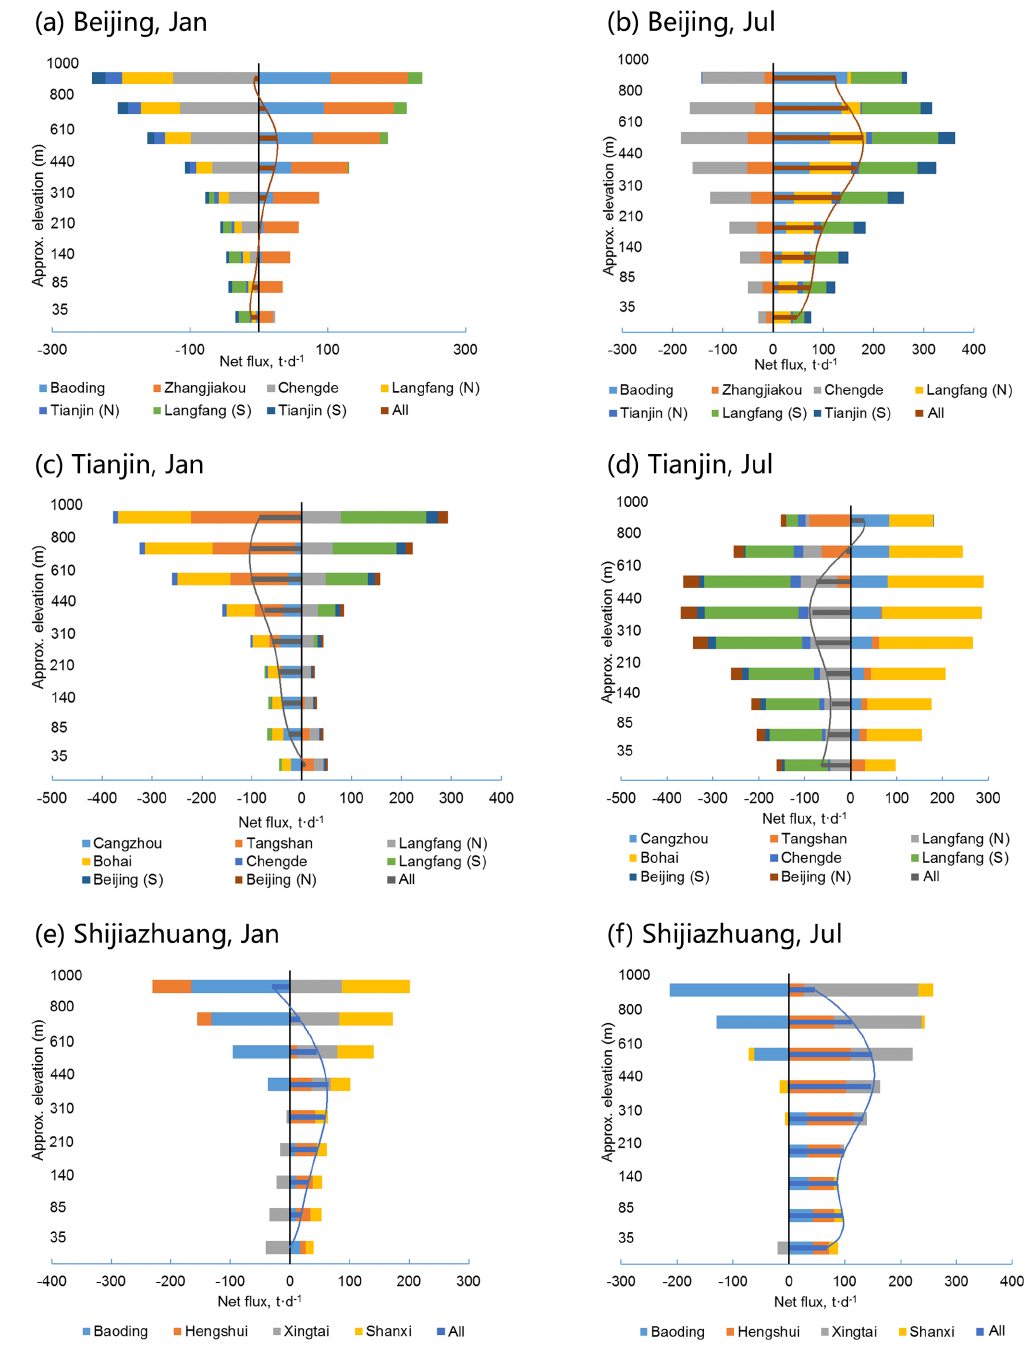
Figure 5. Vertical distribution of net fluxes in January (a, c, e) and July (b, d, f) for (a–b) Beijing, (c–d) Tianjin and (e–f) Shijiazhuang.